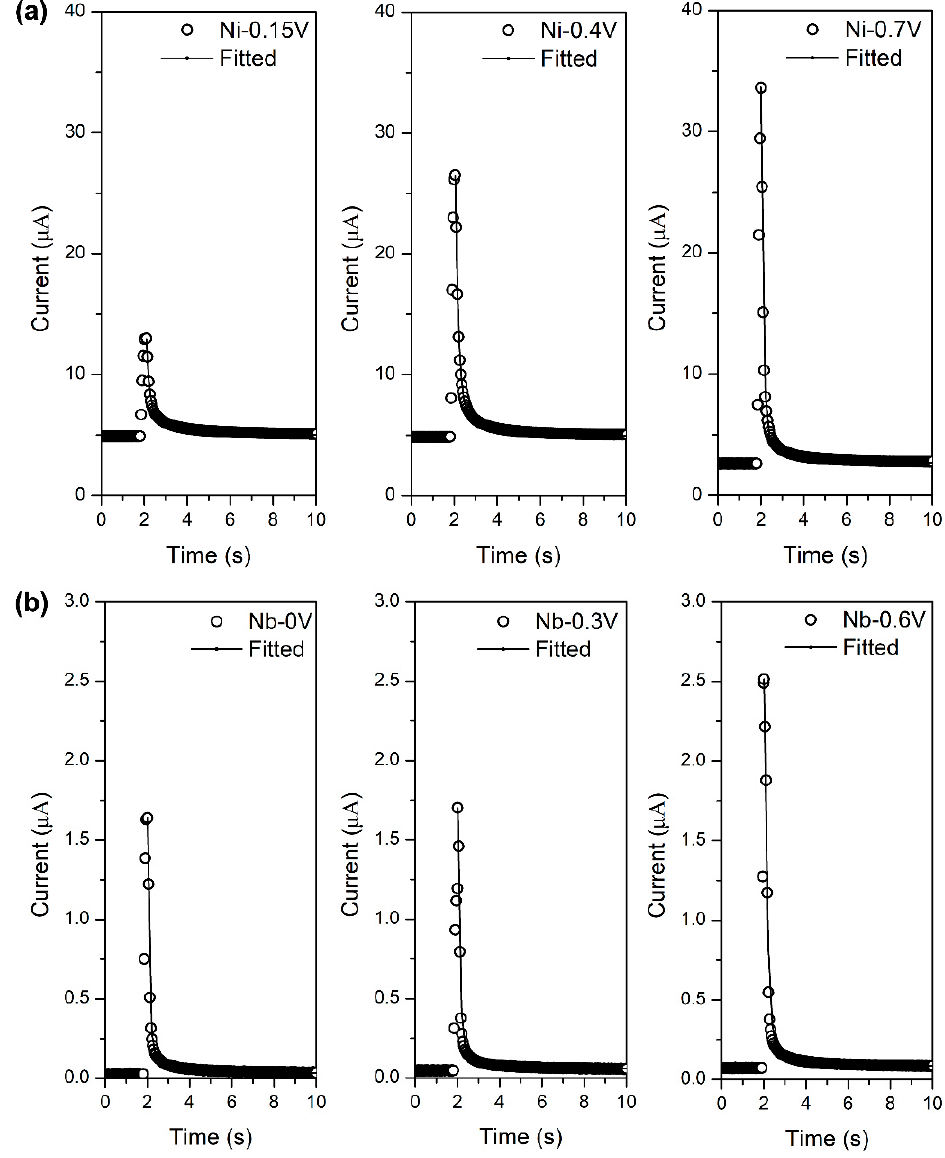
Figure 10. Current curves of ( a ) Ni and ( b ) Nb during the scratching tests at different potentials.